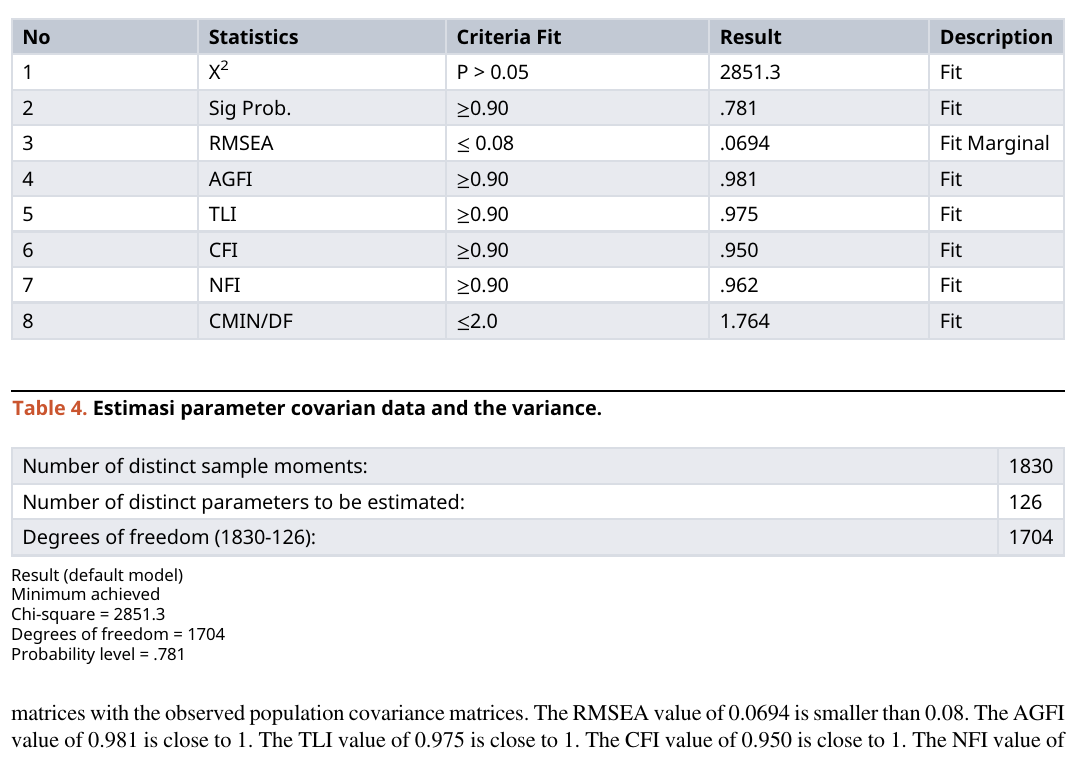
Table 3. Goodness of fit.